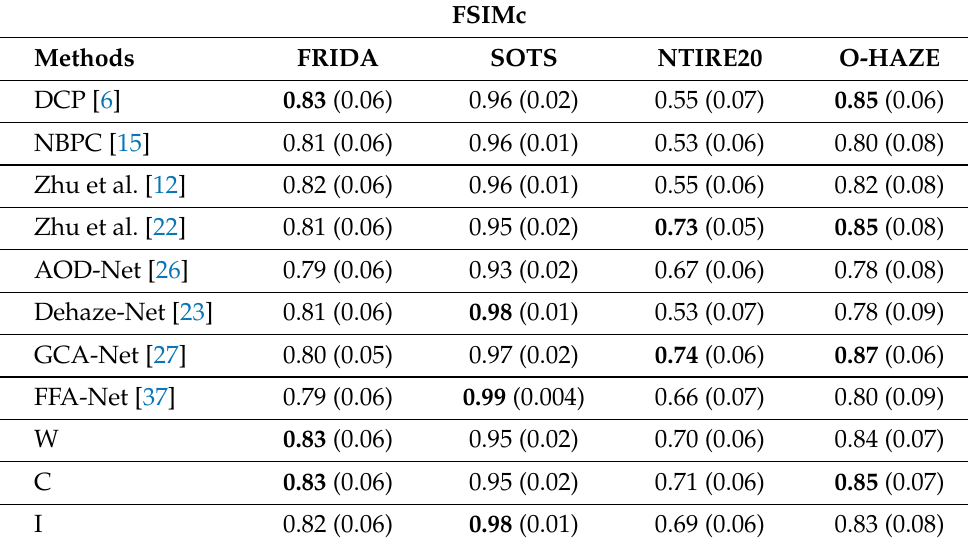
Table 4. Comparison of the FSIMc index on four datasets: fifty images from the FRIDA and the SOTS datasets, forty-five images from the NTIRE20 and the O-HAZE datasets. W corresponds to our main algorithm assuming white fog, and C is the color version (see Section 3.6), and I the interpolated version (see Section 3.5). The best results are in